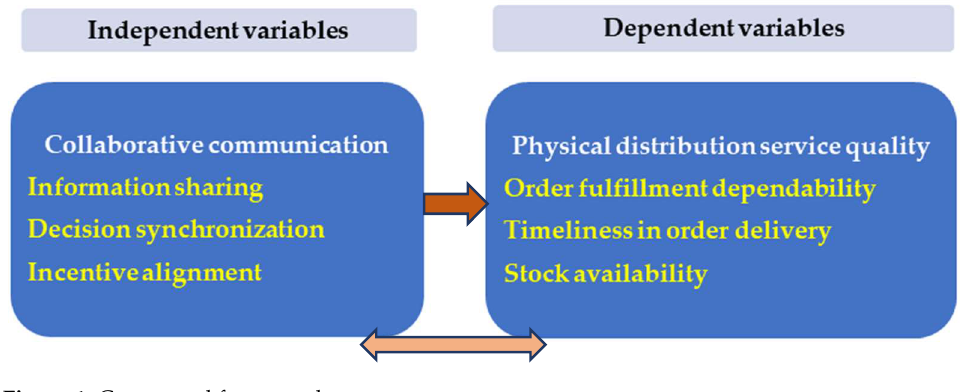
Figure 1. Conceptual